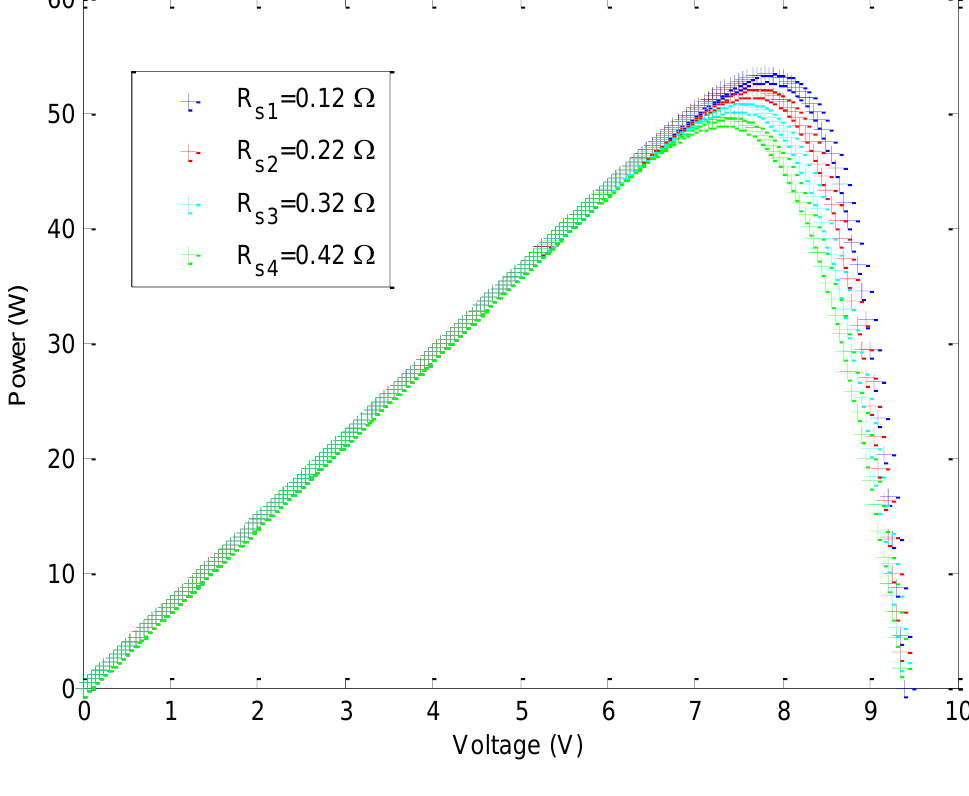
Figure 3. P-V characteristic curves for parametric variation of series resistance.